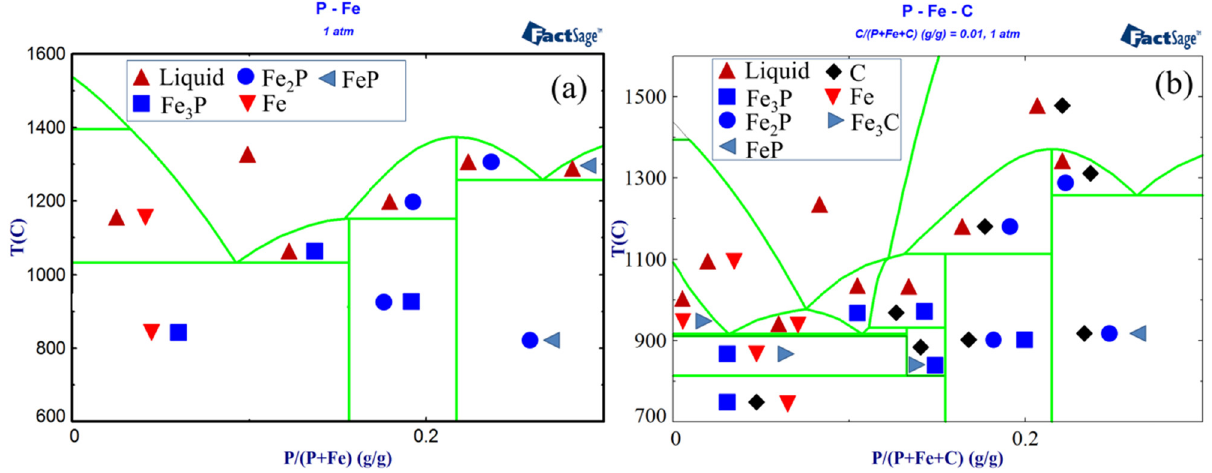
Figure 11: Fe – P binary phase diagram (( a ) [ wt%C ] = 0; ( b ) [ wt%C ] = 1.0 )